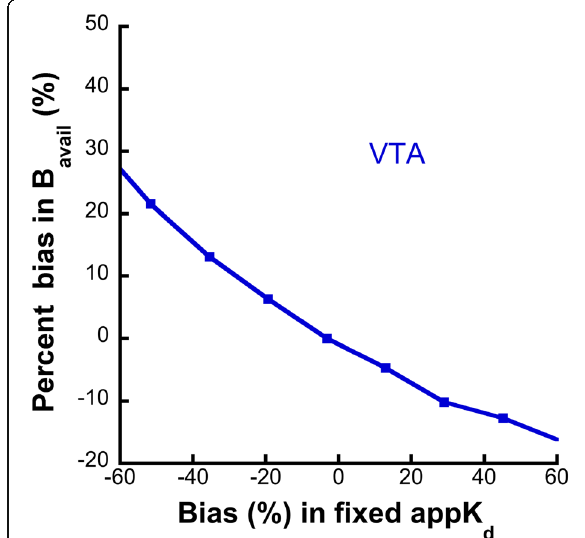
Fig. 5 The potential impact of fixing the appK d value in low-binding regions (here the VTA was employed in the simulation study) for the partial saturation quantification. If the “ true ” appK d of the VOI differs from the fixed value, a bias is introduced in the B avail value estimation. This bias is virtually linearly proportional to the bias in the fixed appK d value